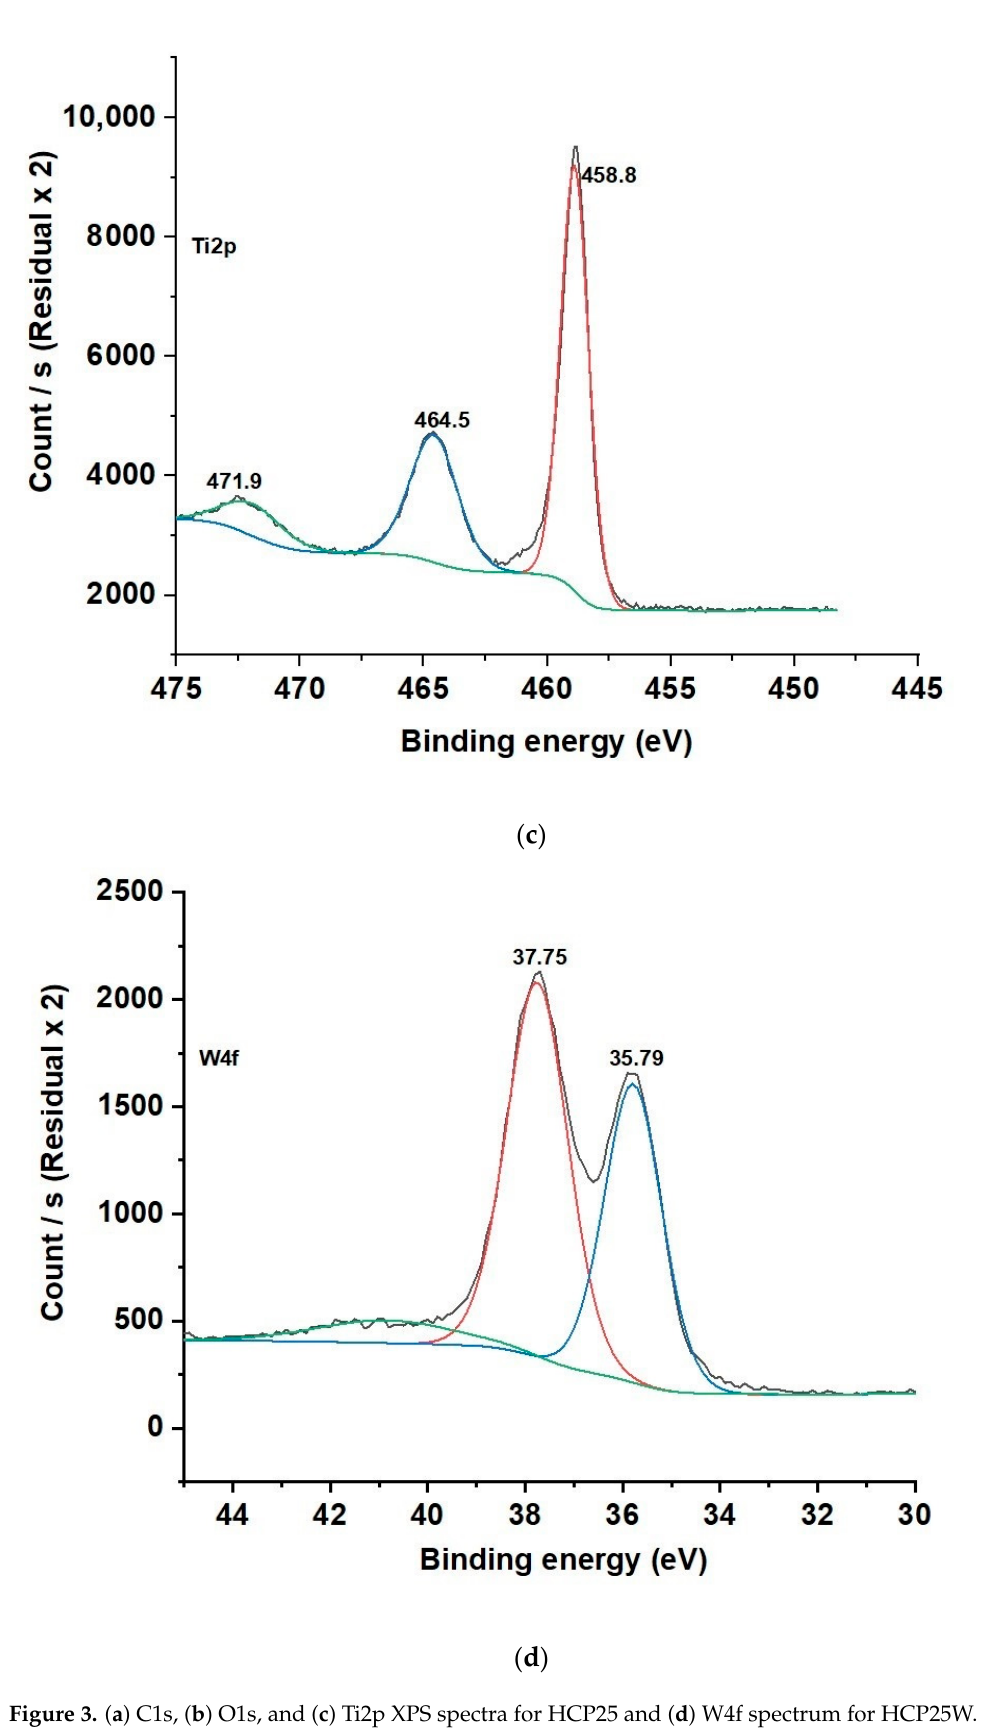
Figure 3. ( a ) C1s, ( b ) O1s, and ( c ) Ti2p XPS spectra for HCP25 and ( d ) W4f spectrum for HCP25W. In HCP25W, W4f can be deconvoluted into two peaks at binding energies of 35.79 and 37.75 eV. These correspond to the W4f 7/2 and W4f 5/2 core levels, which belong to tung- sten with an oxidation state of six (W 6+ ) related to the oxide form of WO 3 [52]. This is consistent with the 719 cm − 1 Raman peak indicating the WO 3 in HCP25W.